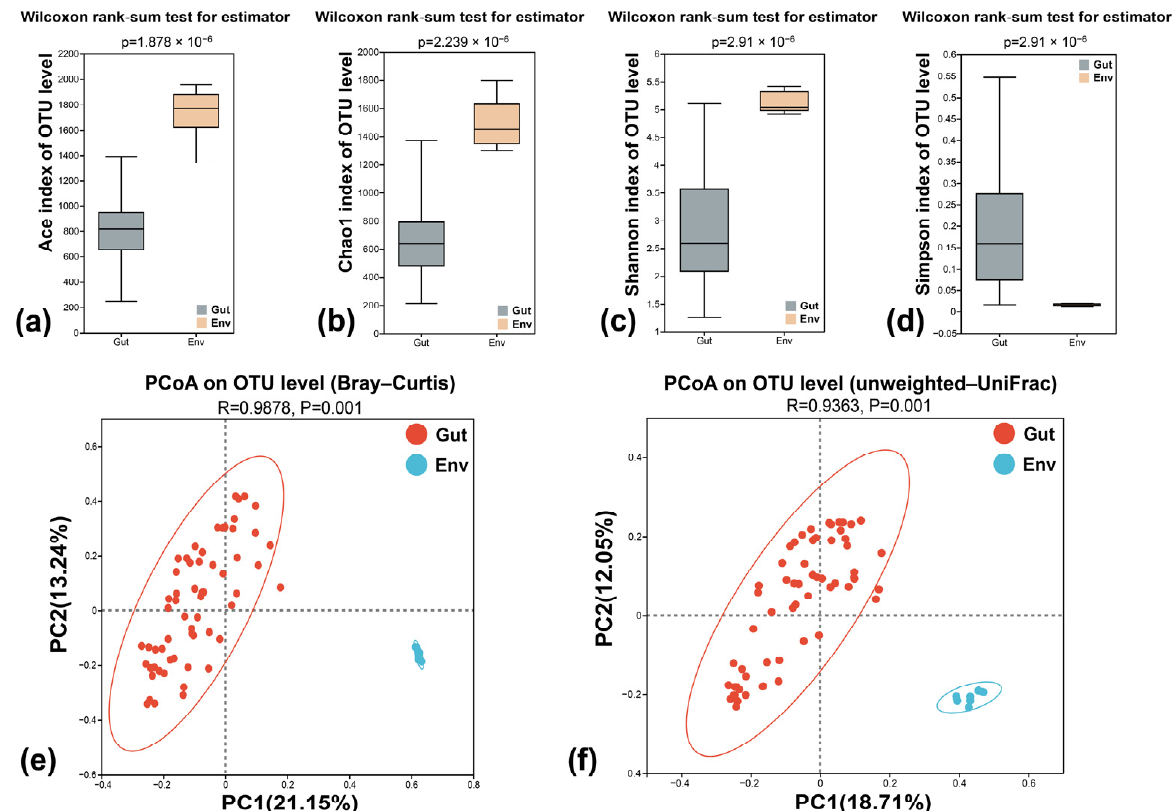
Figure 8. Differences in alpha diversity indexes between gut microbes and surrounding water microorganisms (( a ) Ace, ( b ) Chao1, ( c ) Shannon, ( d ) Simpson). PCoA analysis with ( e ) Bray– Curtis and ( f ) unweighted–UniFrac distances of community composition between gut microbes and surrounding water